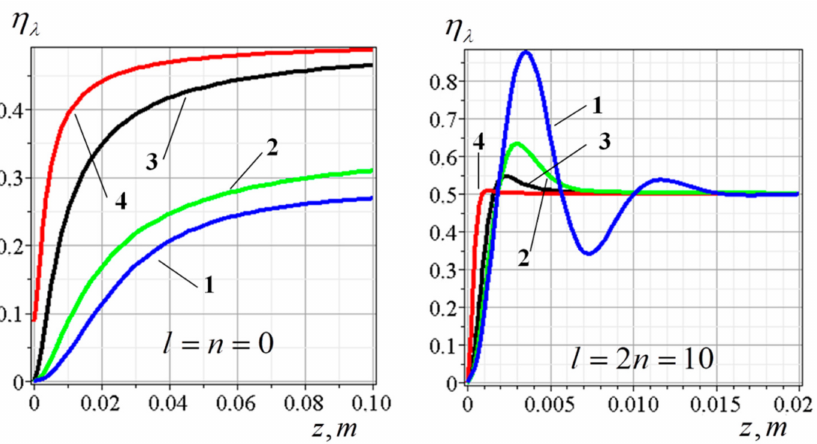
Figure 10. Energy efficiency η λ ( z ) of generation of optical vortices in a quasi-monochromatic Laguerre–Gauss beam with w 0 = 10 mkm propagating in a lithium niobate crystal: (1)— ∆ λ = 10 − 7 m, (2)— ∆ λ = 5 · 10 − 7 m, (3)— ∆ λ = 10 − 6 m, (4)— ∆ λ = 10 − 5